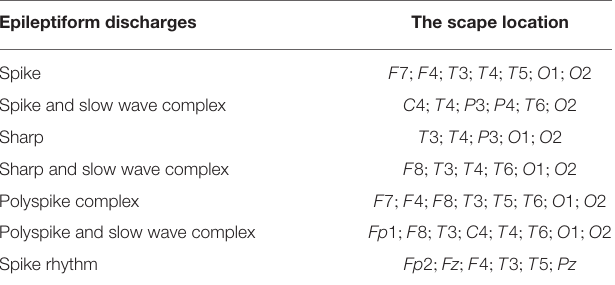
TABLE 5 | The localization of the epileptiform